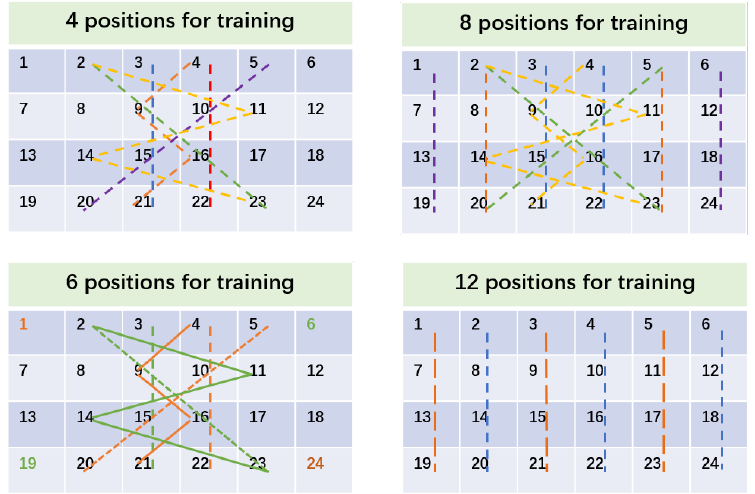
Figure 14. The layout of the training